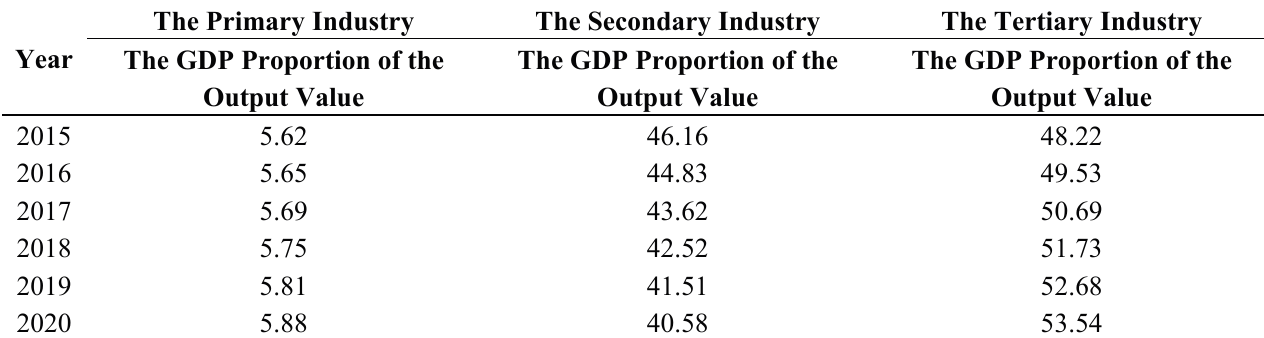
Table 10. Optimization design of the three industrial structures in Shanxi province